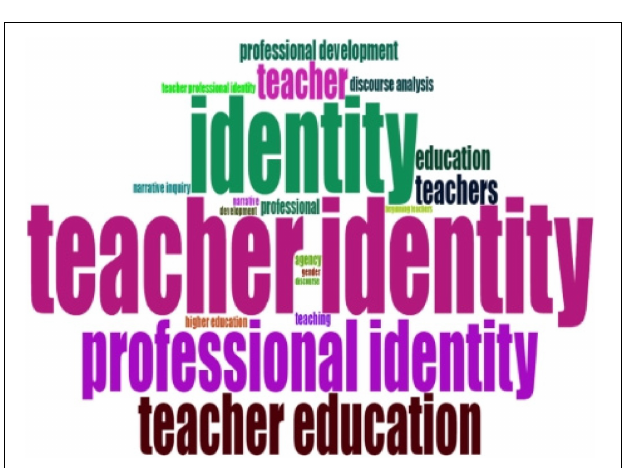
FIGURE 6 | Word Cloud by author’s